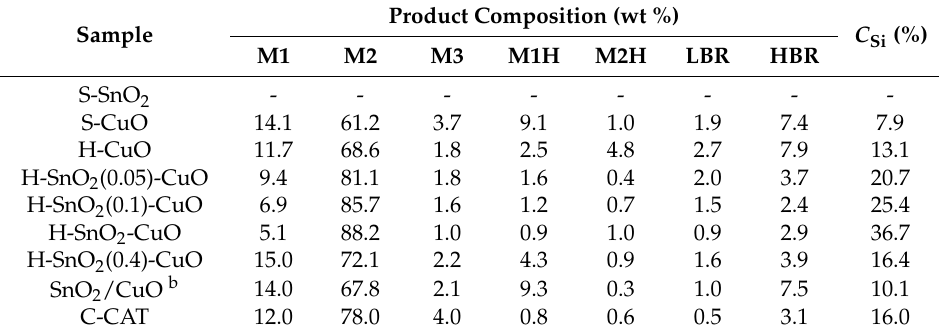
Table 2. The properties of all the catalysts for the Rochow reaction a .